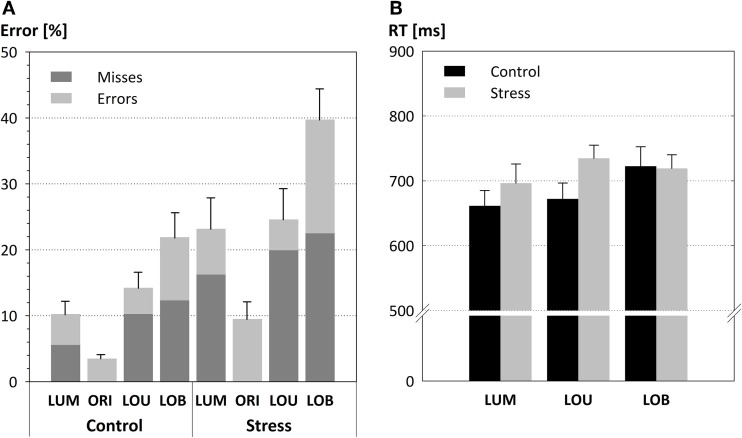
Detection performance in form of mean error rates (A) and response times (B; error bars depict the SE of the mean). Both parameters varied with the strength of the conflict. Error rates but not response times are modulated by the SECPT manipulation. Thus, stress resulted in higher error rates, particularly in the conflict condition LOB. In addition, the stress induction led to an enhanced proportion of response misses (highlighted in dark gray).